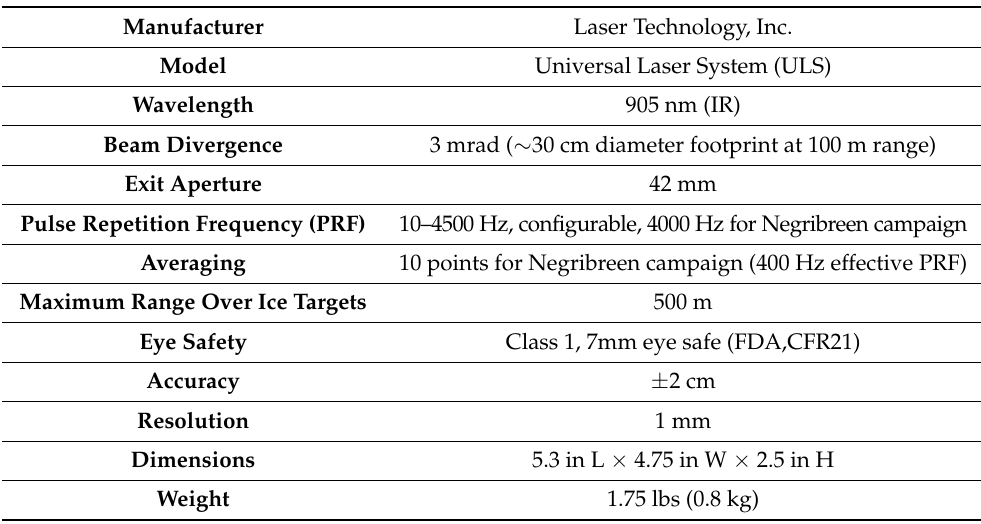
Table 3. Technical specifications of the Universal Laser System (ULS) and settings during the Negribreen airborne geophysical observation and validation campaigns in 2017, 2018 and 2019. FDA—United States of America, Federal Food and Drug Administration, CFR—Code of Federal Regulations Title 21, see https://www.accessdata.fda.gov/scripts/cdrh/cfdocs/cfcfr/cfrsearch.cfm ?FR=1040.10 (accessed on 3 October